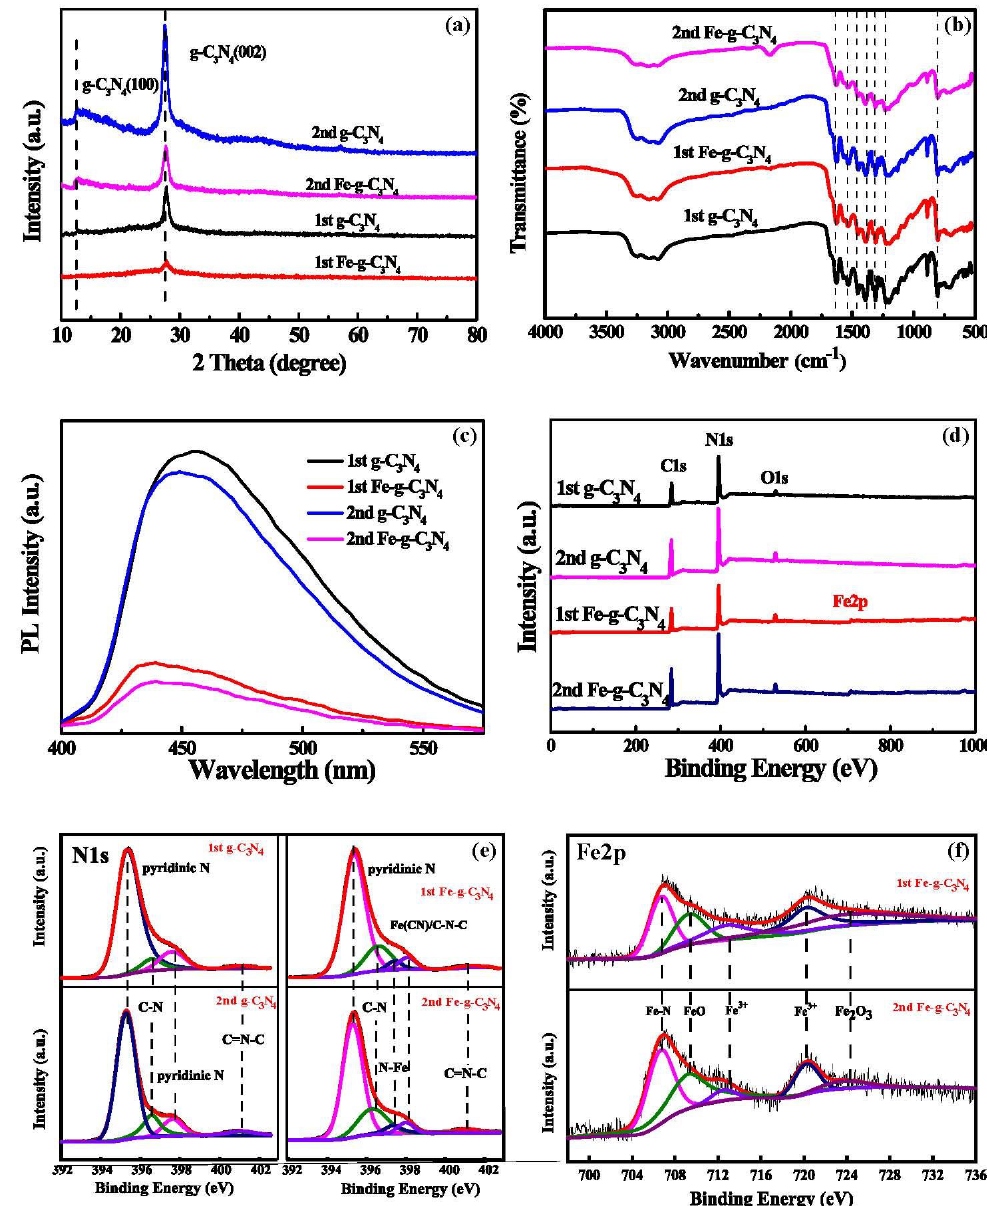
Figure 2. Characterization of one-and two-step g–C 3 N 4 and Fe–g–C 3 N 4 by XRD ( a ); FTIR ( b ),